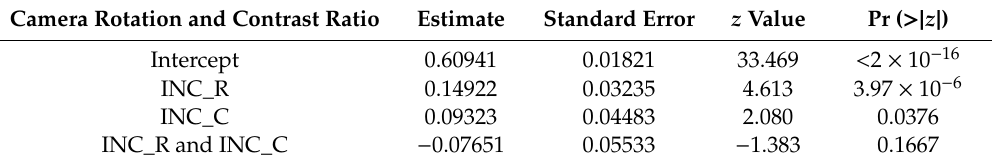
Table 20. Logistic regression analysis results of the additive model using the variables camera rotation and contrast ratio, allowing interactions.